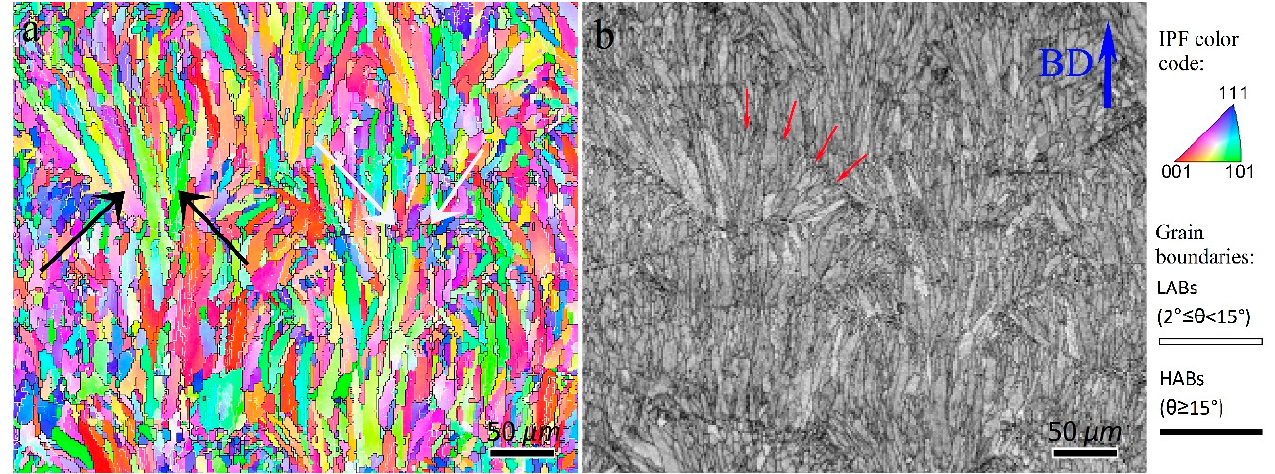
Figure 1. ( a ) Inverse pole figure and ( b ) image quality maps of as-built L-PBF AlSi10Mg. High and low angle grain boundaries are drawn in black and white colors on all inverse pole figure maps through paper, respectively. Black and white in ( a ) arrows show large-elongated and fine-equiaxed grains. Red arrows in ( b ) refer to the region of the melt pool boundary.